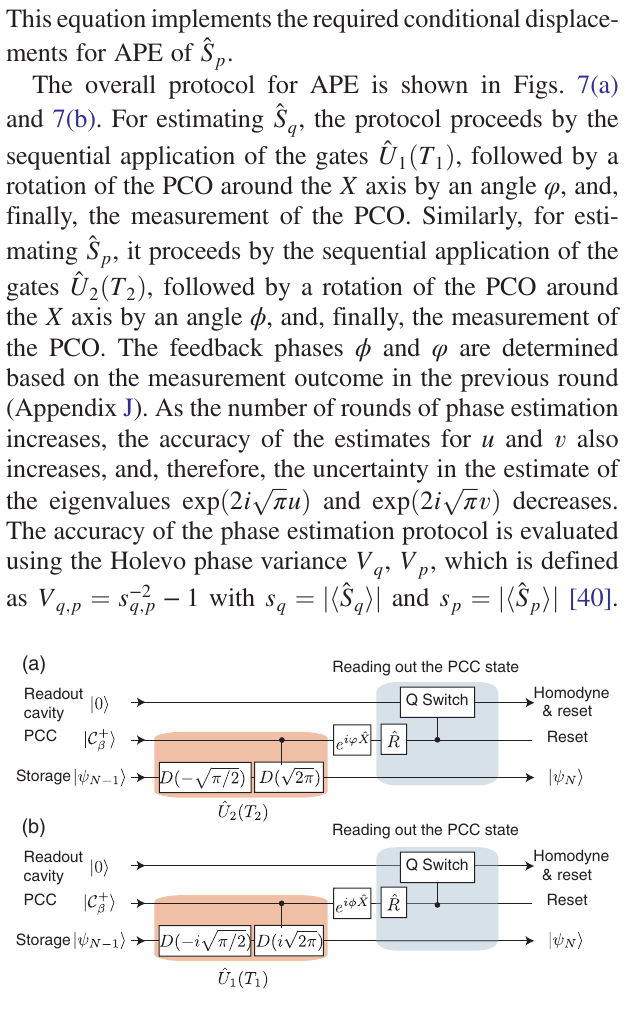
FIG. 7. (a),(b) show the overall protocol of estimating the ˆ ˆ S S and , respectively, with the PCO. It proceeds eigenvalues of p q ˆ U ˆ U by the sequential application of the gates 2 ð T 2 Þ [or 1 ð T 1 Þ ] and the measurement of the PCO. In APE, the state of the PCO is rotated by an angle ϕ or φ around the X axis of the Bloch sphere before each measurement. The angles ϕ and φ are chosen based on its previous measurement